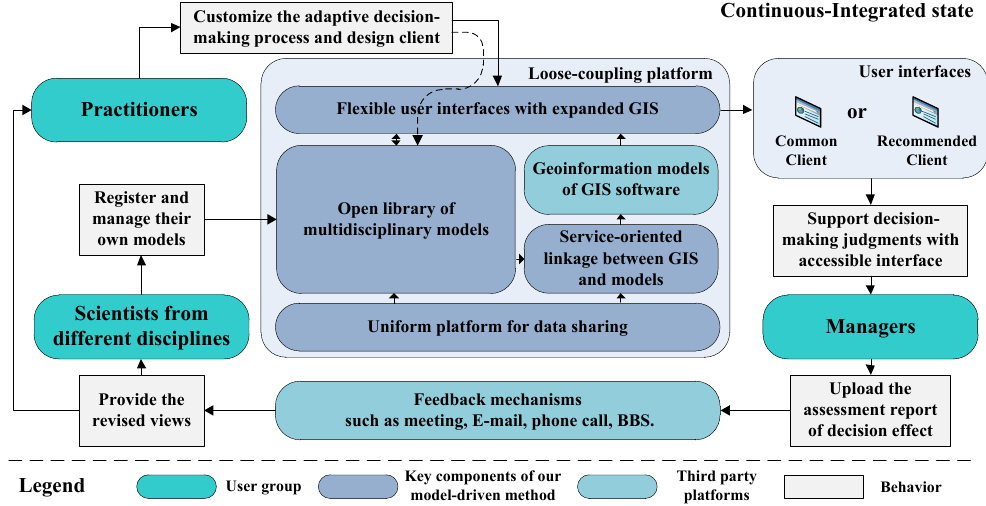
Fig. 1. Behavioral aspects of the model-driven method for flood risk management.